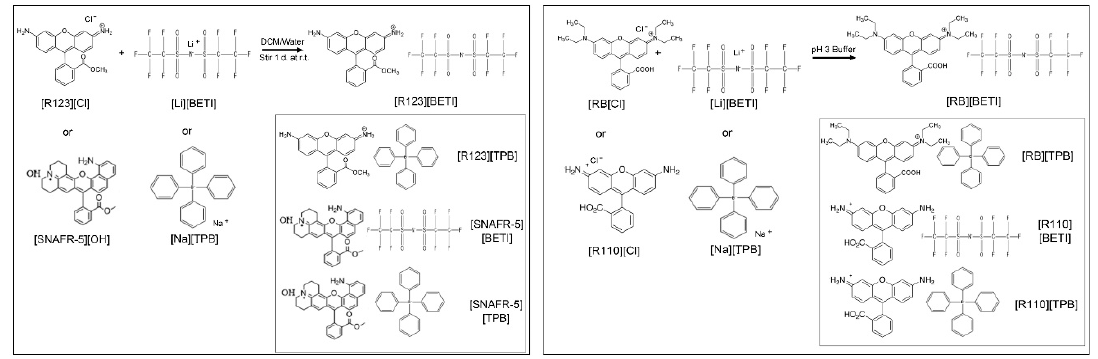
Figure 1. Synthesis of R123, SNAFR-5, RB, and R110 group of uniform materials based on organic salts (GUMBOS). Table 1. Zeta potential of R123 and SNAFR-5 nanoGUMBOS .